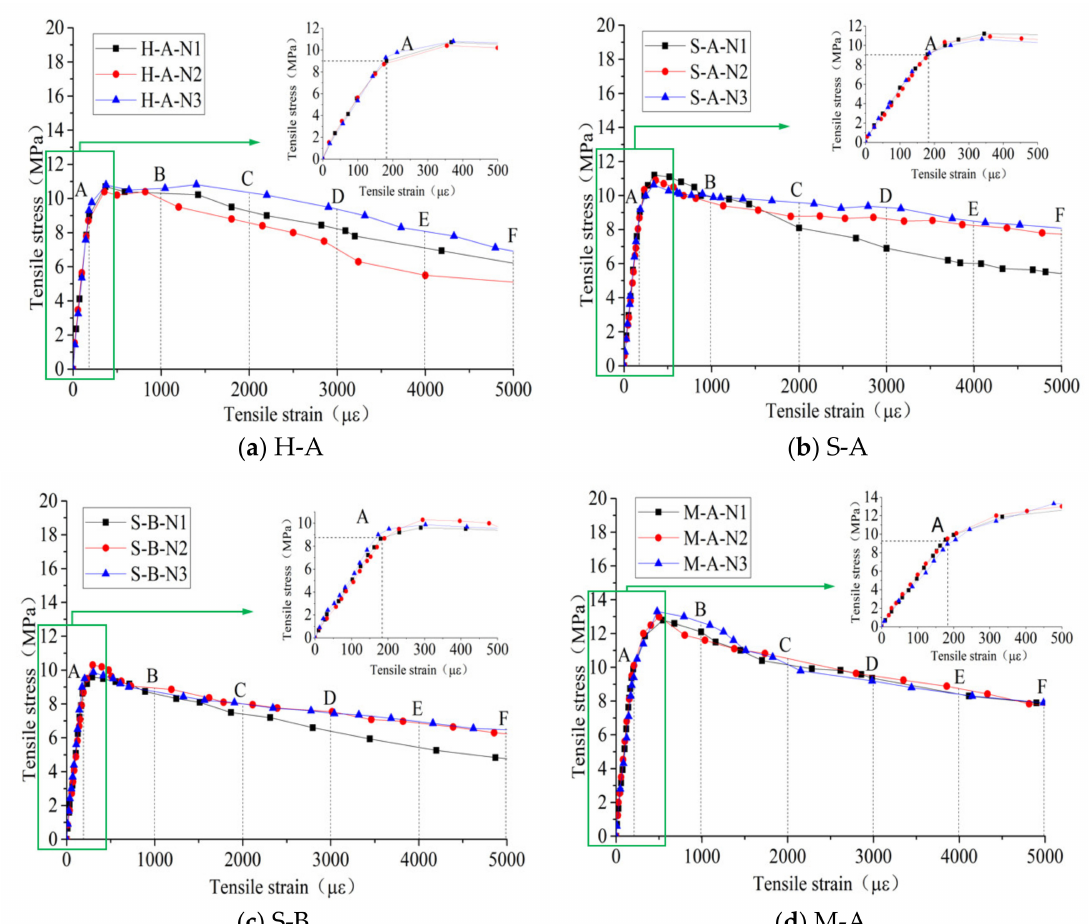
Figure 4. Direct-tensile-stress–strain measured